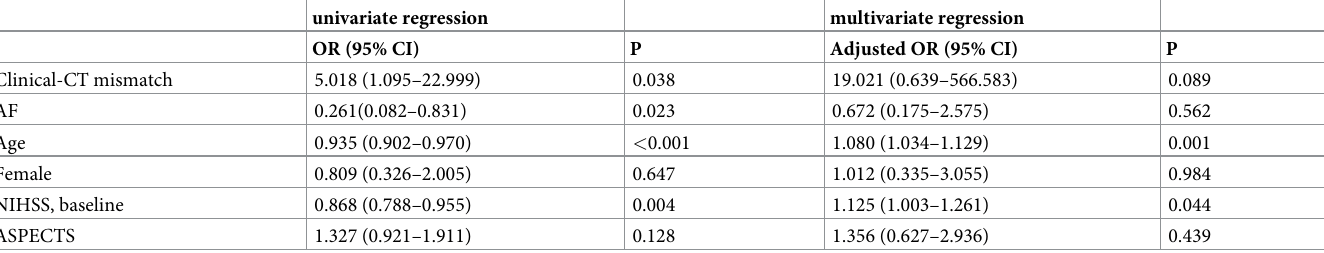
Table 6. Univariate and multivariate logistic regression analysis for predicting the favorable outcome (mRS �